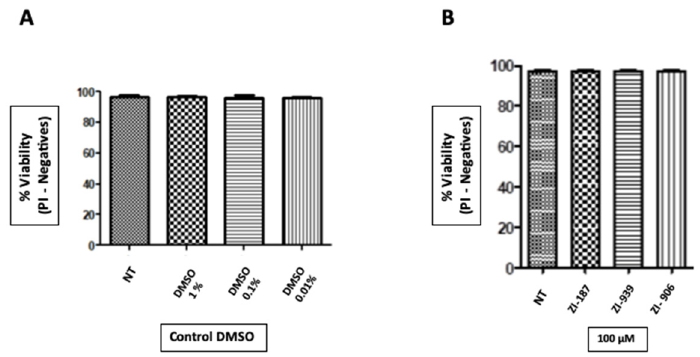
Figure 4. Cytotoxicity assay on periodontal ligament fibroblast cells (PLF). ( A ). Evaluation of compounds solvent cytotoxicity (DMSO 1%, 0.1% and 0.01%). NT: Not-treated. ( B ). Cytotoxicity evaluation of compounds (100 µM) ZI-187 ( p = 0.7372), ZI-939 ( p = 0.8) and ZI-906 ( p = 0.7964) on PLF, by laminar flow cytometry analysis with Propidium Iodide.